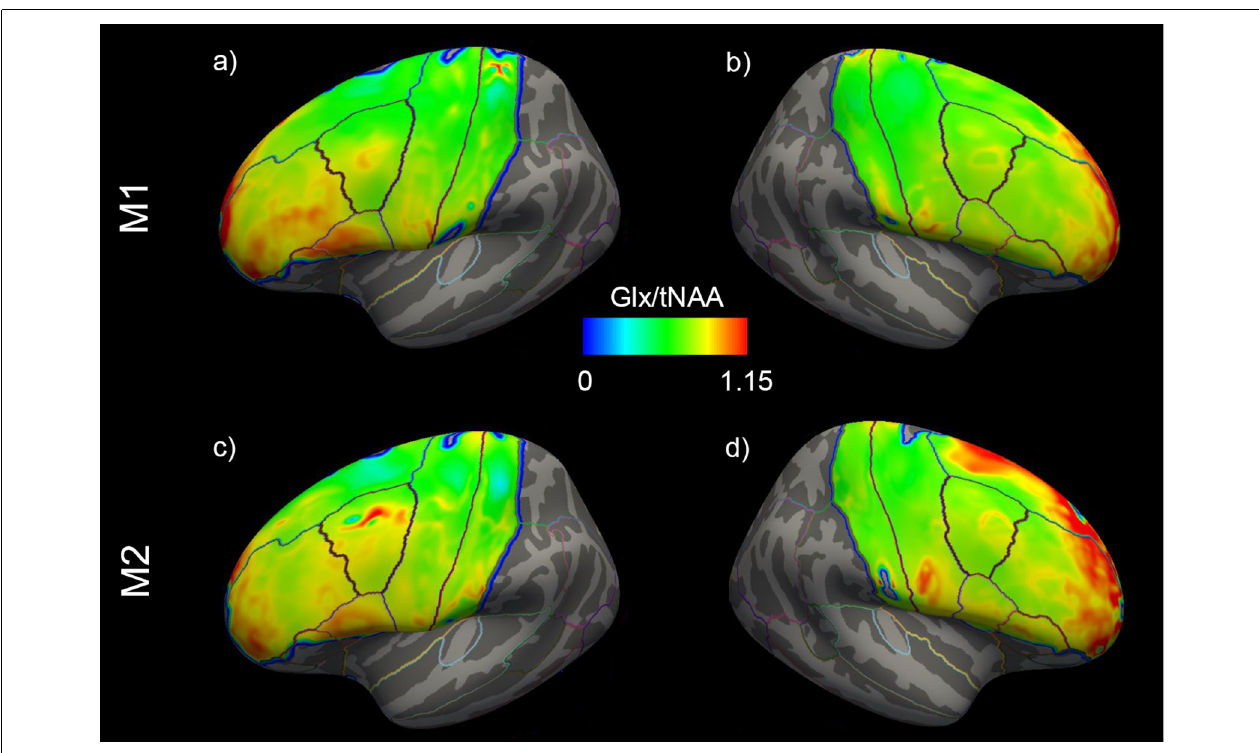
FIGURE 5 | Mean distribution of Glx/tNAA ratios before (=M1) and after (=M2) the treatment period of the left (A,C) and right (B,D) hemispheres. Glx, combined measure of glutamate and glutamine; Tnaa, total